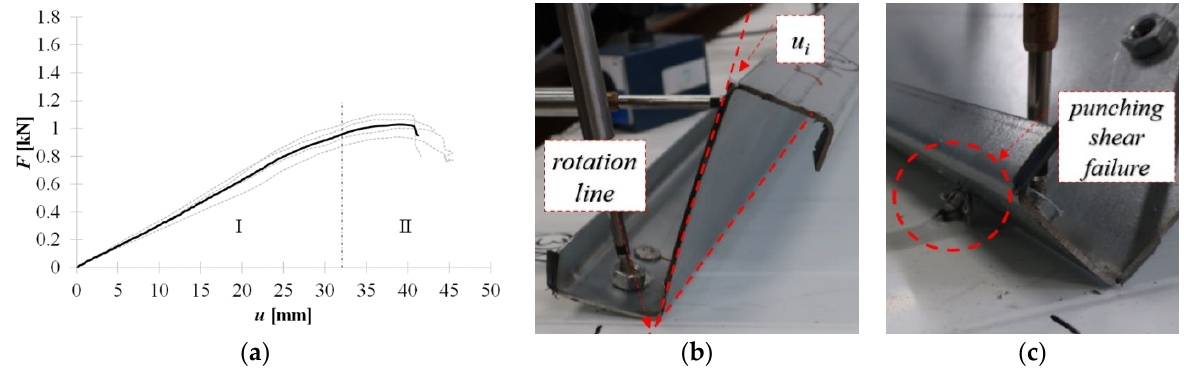
Figure 14. Pulled blind rivet: ( a ) equilibrium load ‐ displacement paths, ( b ) cross ‐ section rotation at stage I, ( c ) punching shear failure at stage II.